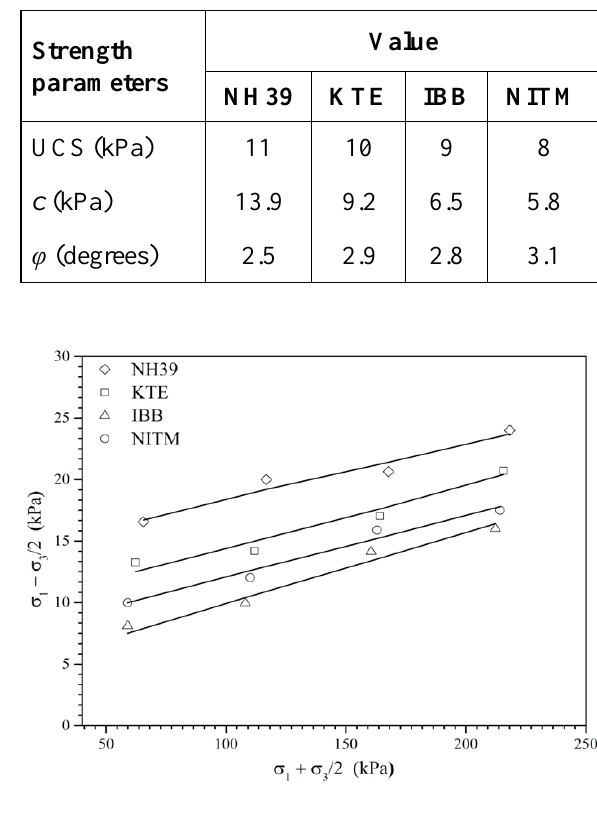
Figure 3. Water content - dry density relationship for Northeast Indian peats.